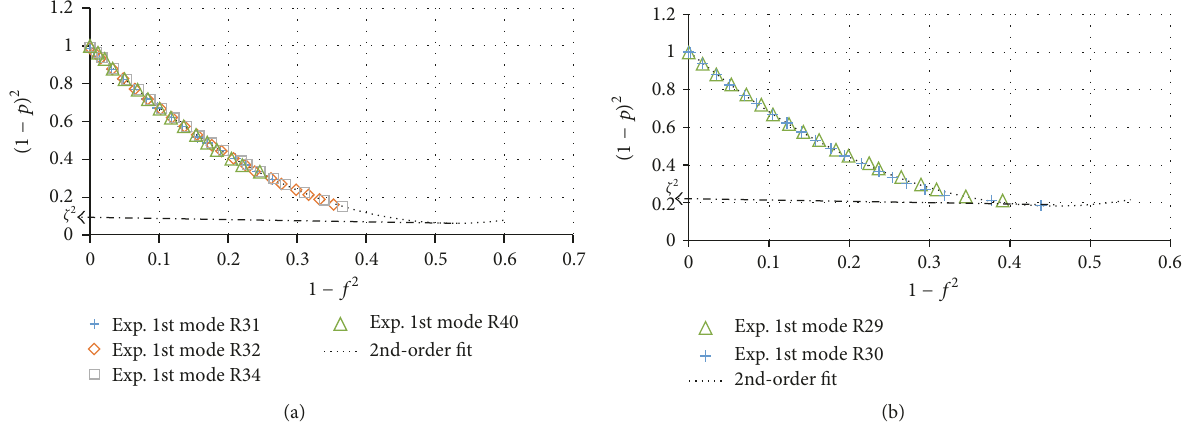
Figure 12: Plot of (1 − 𝑝) 2 as a function of 1 − 𝑓 2 and the second-order fit for the sets of cylinders with comparatively small (a) and larger (b) imperfections.